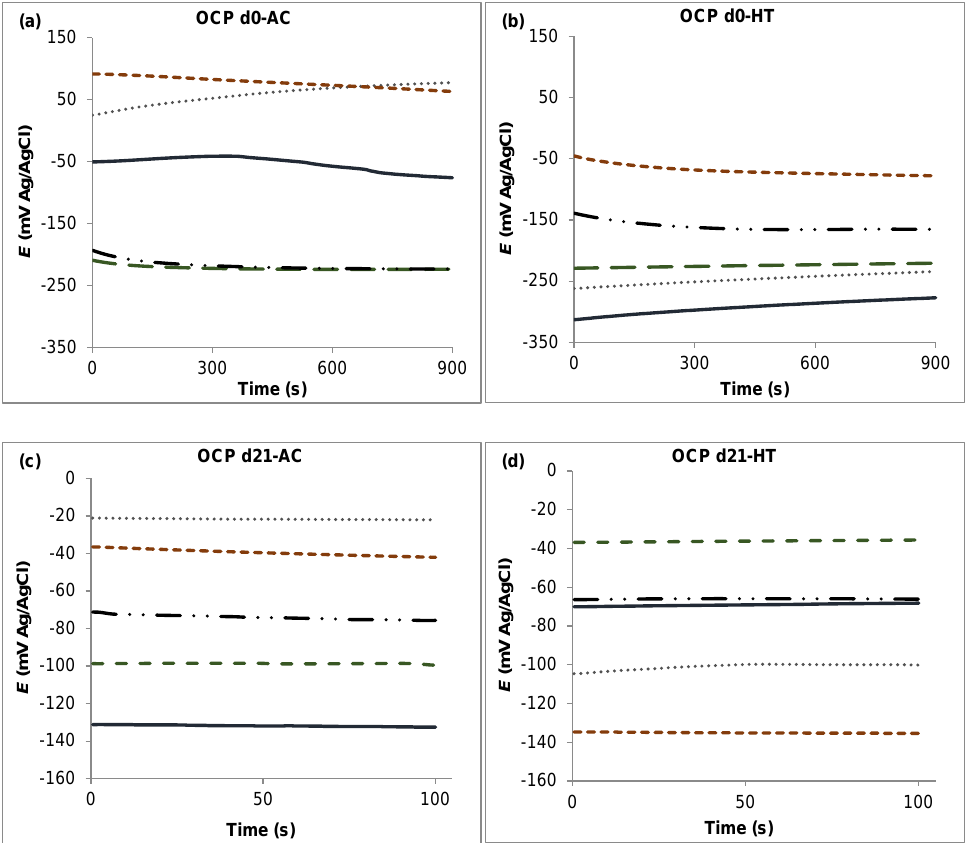
Figure 5. Open circuit potential (OCP) results. ( a ) As-cast and ( b ) heat-treated alloys at Day 0 of immersion, and ( c ) as-cast and ( d ) heat-treated alloys at Day 21 of immersion; (—) 0B, (– –) 0.06B, ( ···· ) 0.25B, (- - - -) 0.5B, and (– · · ) 1B.